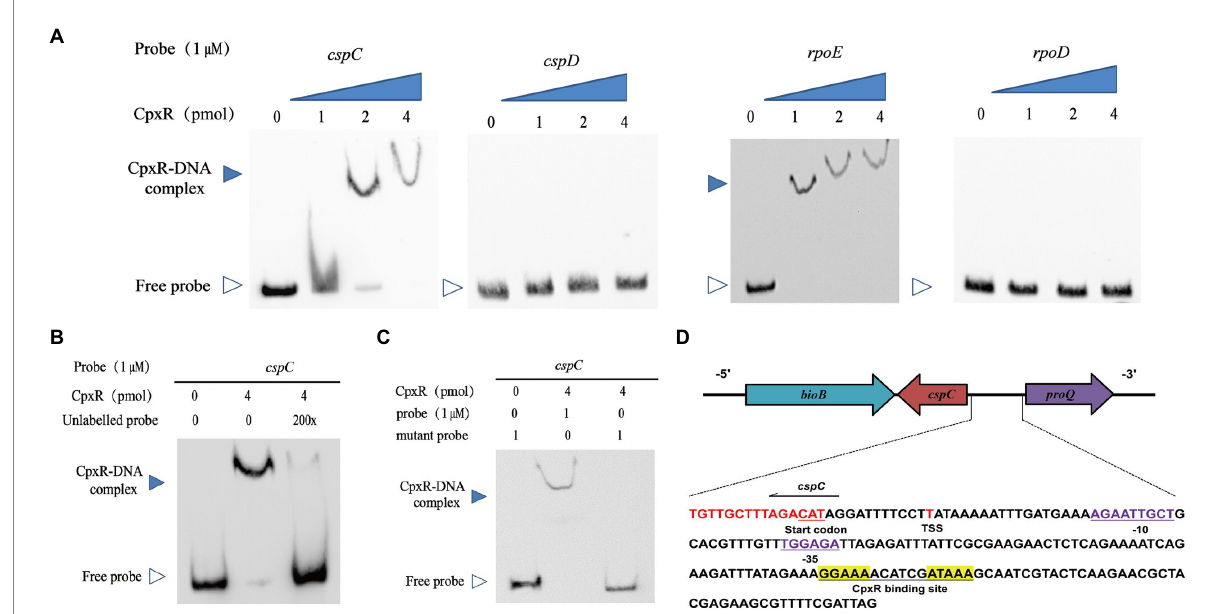
FIGURE 4 CpxR binds promoter of cspC but not that of cspD . (A) EMSAs analysis of the binding affinity of various amounts of CpxR-P with the cspC , cspD , rpoE (positive control), rpoD (negative control) promoter regions. (B) EMSAs analysis of the binding of CpxR-P with the cspC promoter region under adding excess amounts of unlabeled probes. (C) Labeled mutant cspC promoter region were incubated with various concentrations of CpxR-P. (D) Characterizing the CpxR binding site. The putative CpxR binding site is underlined and shown in yellow background. The − 35 and − 10 box are underlined and shown in purple nucleotides. The transcription start site (TSS) is shown in red.